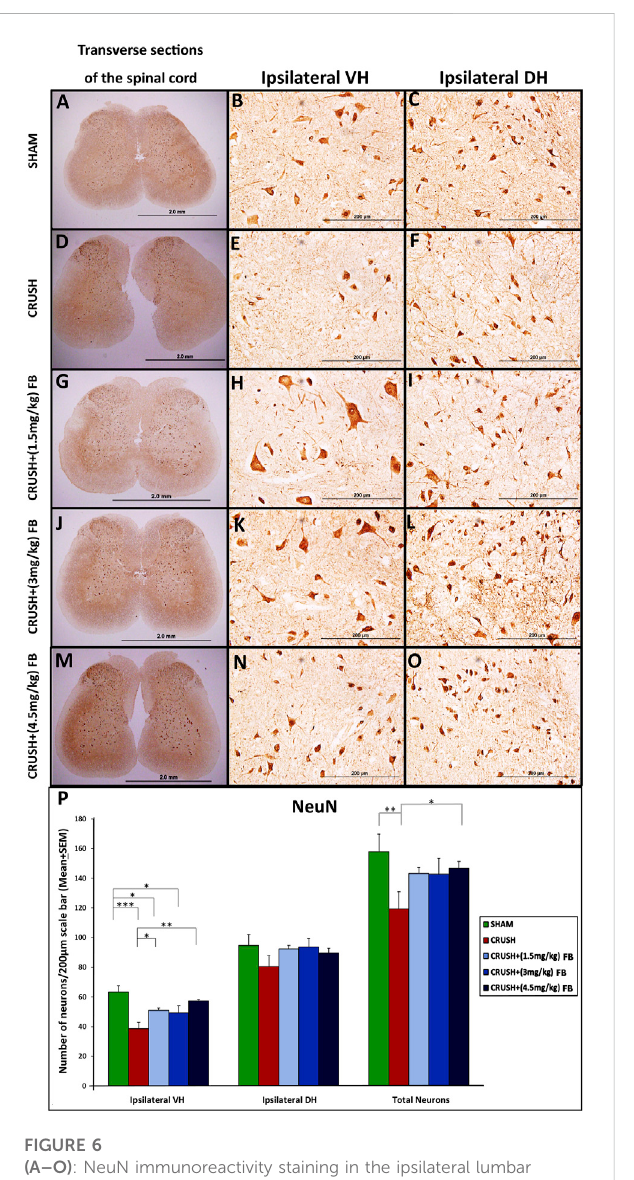
FIGURE 6 (A – O) : NeuN immunoreactivity staining in the ipsilateral lumbar spinal cord regions after sciatic nerve crush injury in all experimental groups (A – O) . NeuN-positive neurons are identi fi ed as brown cells (Magni fi cation ×4 and 40x). (P) Means of labeled NeuN immunoreactive neurons/ fi eld in the spinal cord sections of rats subjected to sciatic nerve crush injury. NeuN neuronal count was less in the CRUSH group after sciatic nerve crush injury. There were no signi fi cant differences in neuronal loss in the FB-treated rats. Data are expressed as mean ± SEM. * p < 0.05, ** p < 0.01, and *** p < 0.001.